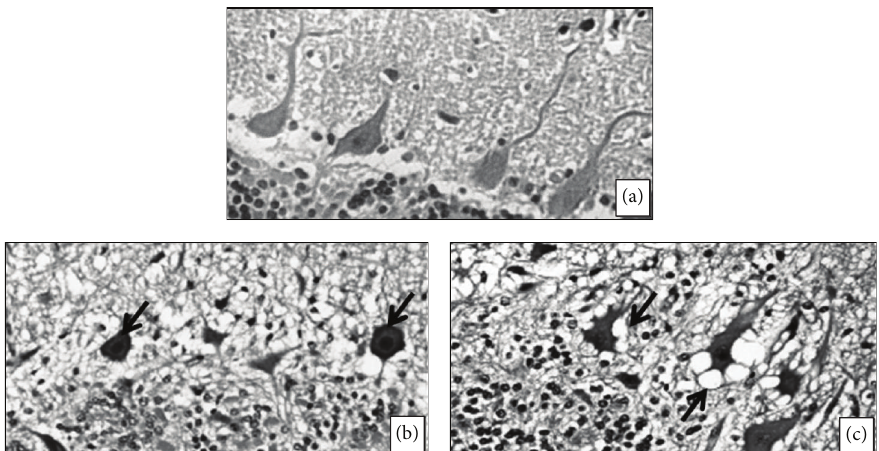
Figure 2: Light photomicrograph of pregnant sows CNS: (a) animal from control group; ((b) and (c), resp.) animals treated with 4.0 and 6.0 mg/kg of body weight of cyanide from day 21 of pregnancy to 110 term showing Purkinje cells with acidophilic cytoplasm (arrow; (b)) and vacuolar degeneration of Purkinje cells (arrow; (c)). Magnification: × 20, HE.